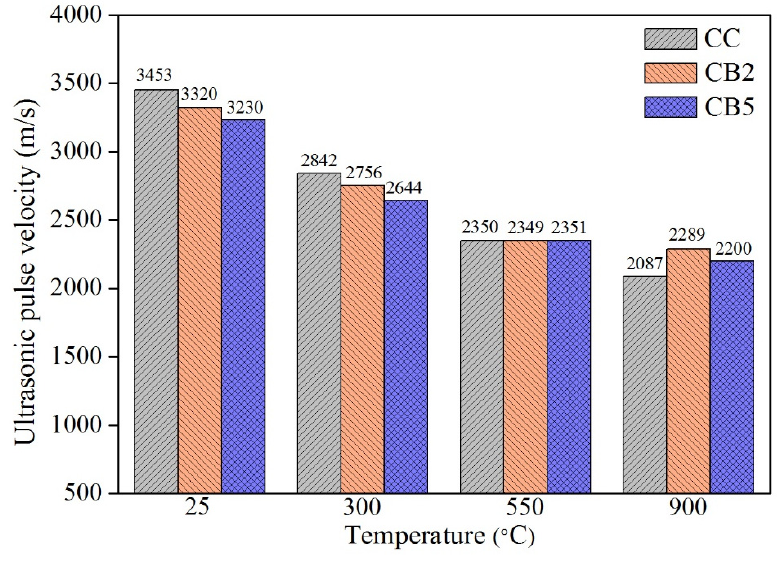
Figure 4. UPV of the paste specimens exposed to 20, 300, 550 and 900